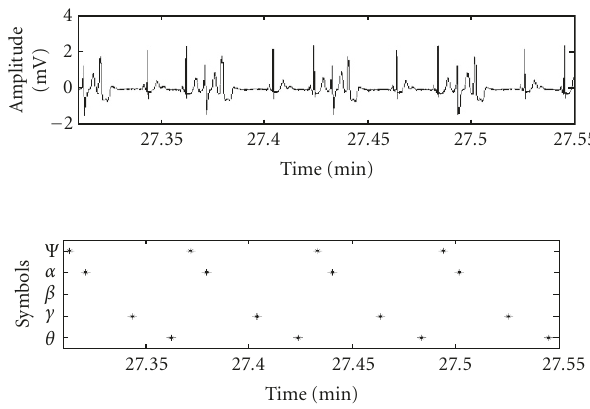
Figure 12: A patient with recurrent tachyarrhythmic episodes. These episodes appear in the raw tracing as dense regions, corre- sponding to an increased number of heart beats during these peri- ods owing to faster heart rate.